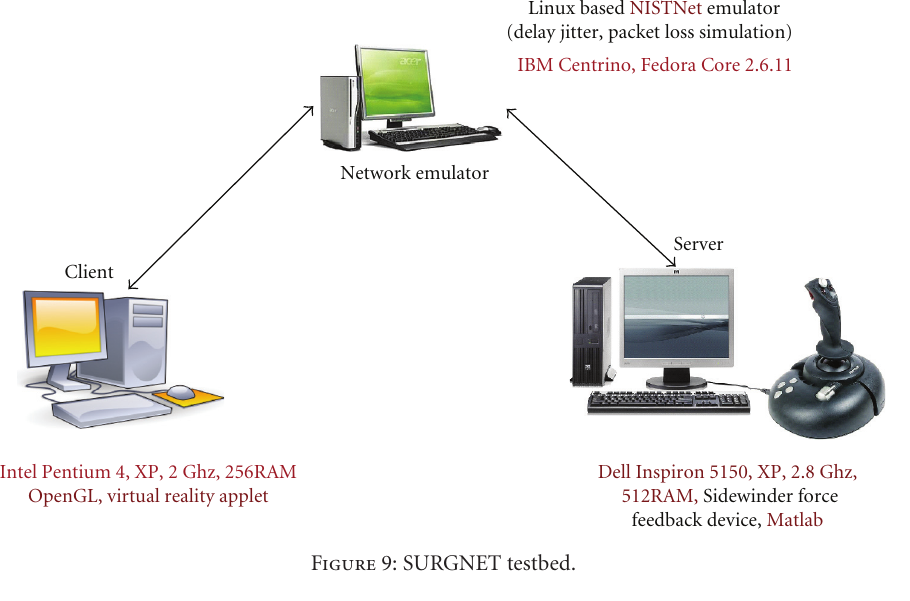
Figure 9: SURGNET testbed.